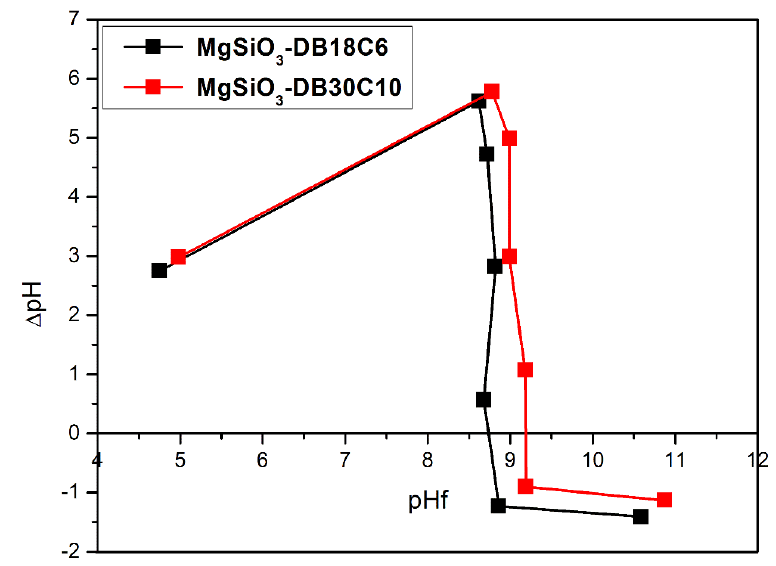
Figure 5. Point of zero charge (PZC) for the functionalized adsorbent.